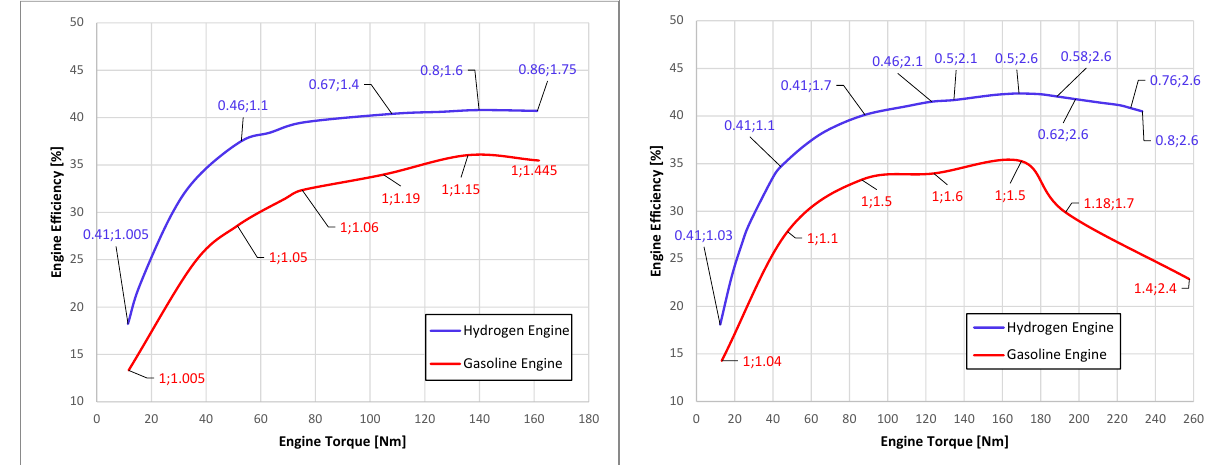
Figure 7. Engine efficiency as a function of the engine torque at 1500 rpm ( left ) and 3000 rpm ( right ). Equivalence ratio and boost pressure values ( φ ;BP) are highlighted for some operating points.